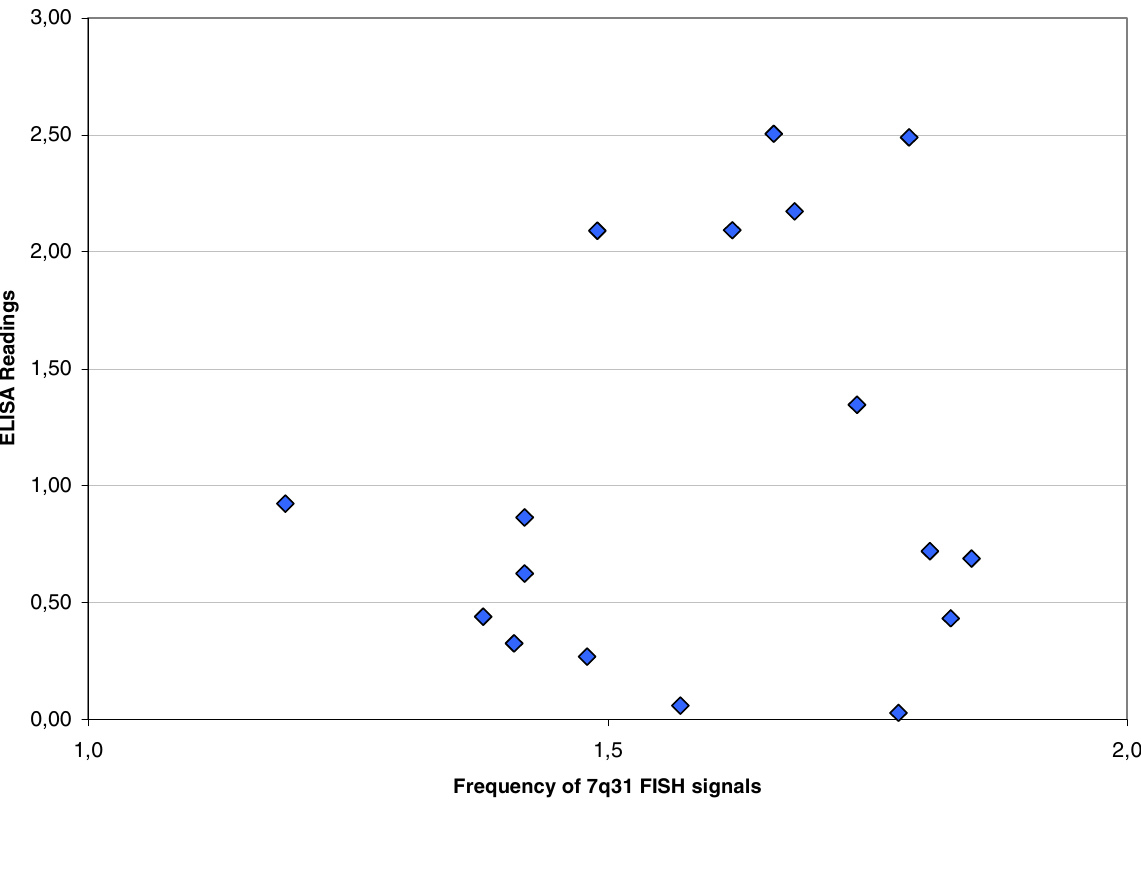
Figure 3 Correlation between ELISA readings for telomerase activity and the frequency of 7q31 FISH signals in individual samples from the 7q-